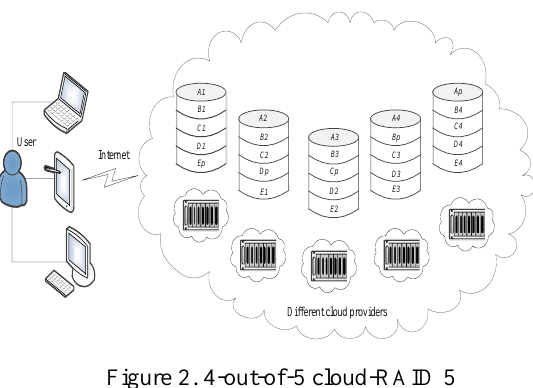
Figure 2. 4-out-of-5 cloud-RAID